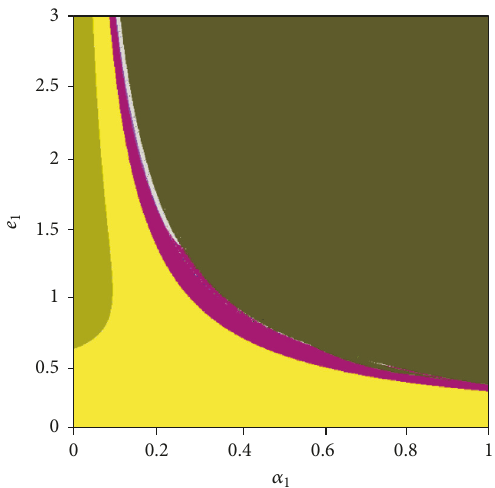
Figure 4: (𝑒 1 ,𝛼) -2D bifurcation diagram with 𝛽 = 0.2 and 𝛾 = 0.1 .